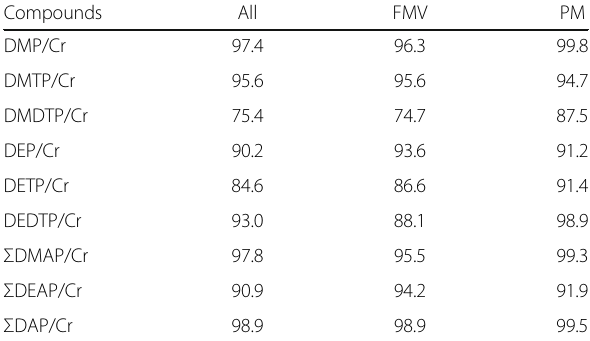
Table 4 Surrogate category analyses based on a single